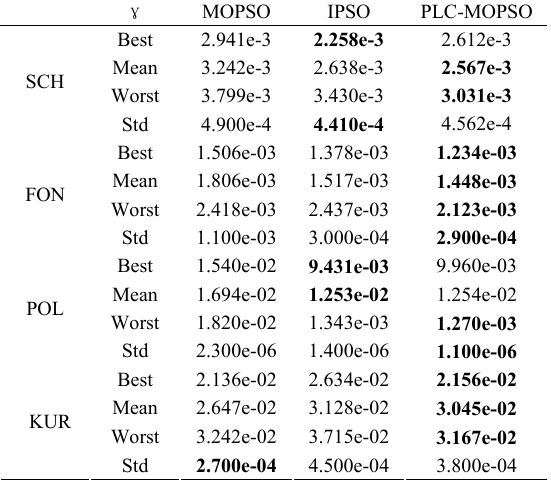
Table 3 Results of the convergence metric for test problems